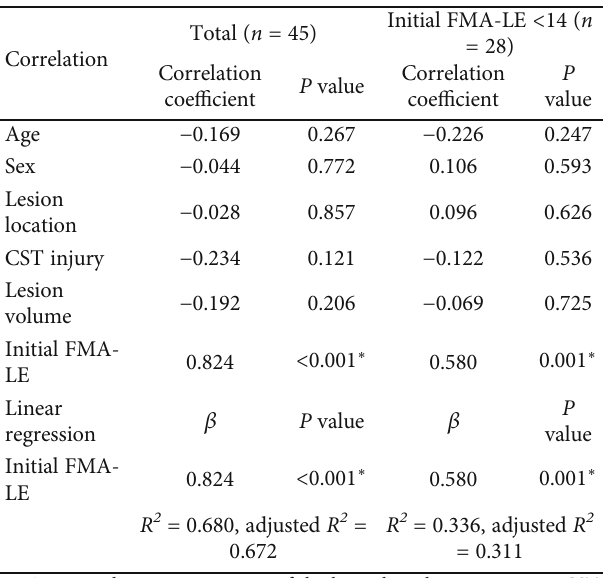
Figure 3: Follow-up Fugl-Meyer assessment of the hemiplegic lower extremity (FMA-LE). (a) Linear regression between corticospinal tract (CST) injury and follow-up FMA-LE scores. The symbols indicate the same patient clusters as those shown in (b). The regression is not found, even after the exclusion of patients with an initial FMA-LE score of ≥ 14 ( ■ ). (b) Hierarchical clustering between initial and follow-up FMA- LE scores shows three clusters ( ■ , □ , and × ). The solid line is the line of identity. Table 3: Correlation and regression analyses between FMA-LE and other